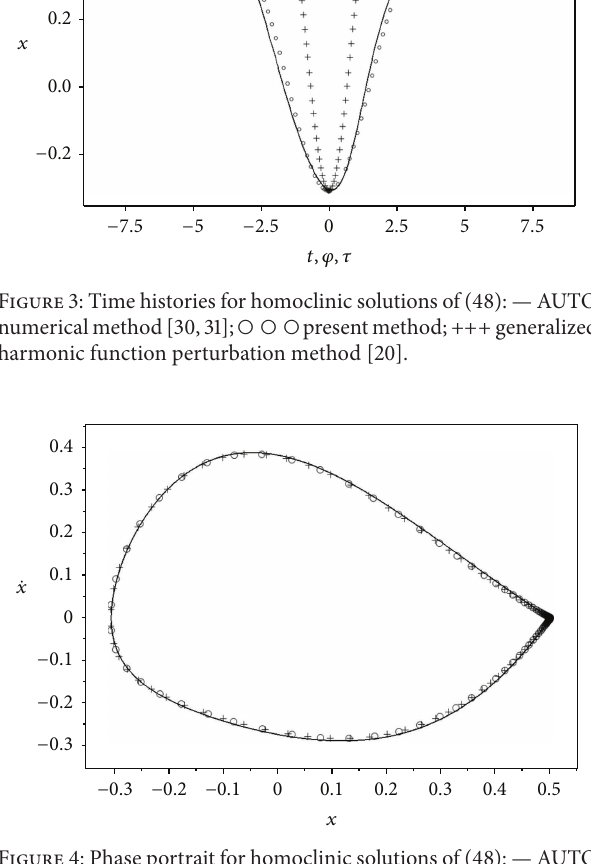
Figure 4: Phase portrait for homoclinic solutions of (48): — AUTO numericalmethod[30,31]; I I I presentmethod; +++ generalized harmonic function perturbation method